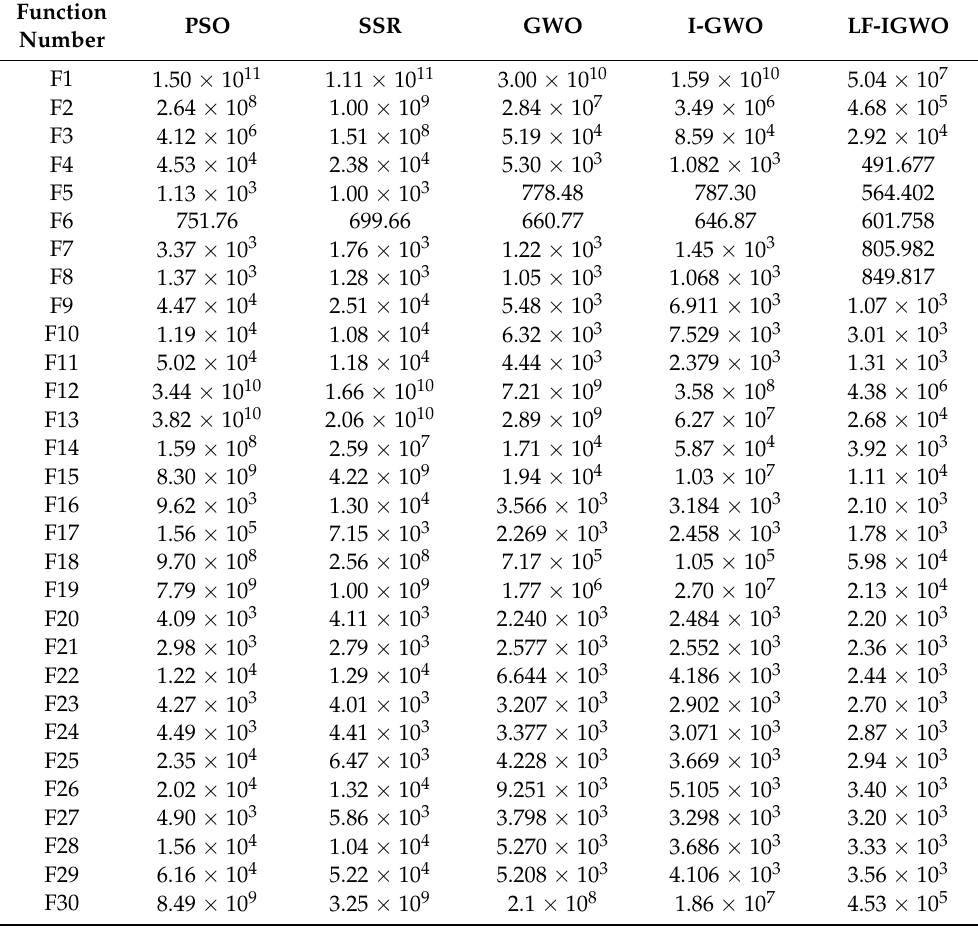
Table 7. Comparison of mean values obtained from CEC 2017 benchmark